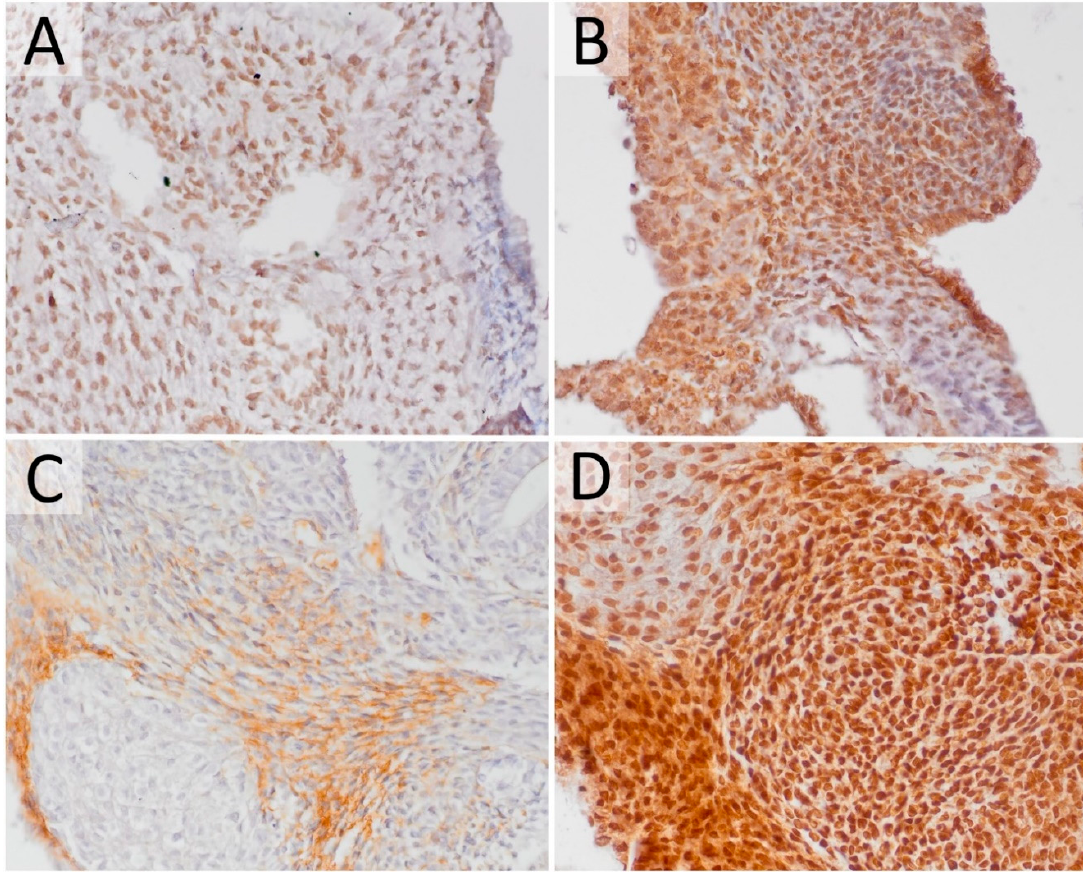
Figure 2. Experimental mouse teratoma gene expression on the protein level. ( A ) Most cells exhibit a positive signal for POU5F1 (IHC, 400×); ( B ) most cells exhibit a positive signal for NANOG (IHC, 400×); ( C ) cytoplasmic positivity of p53 in differentiated cells (IHC, 400×); ( D ) most cells exhibit a positive signal for 8-OHdG (IHC, 400×).